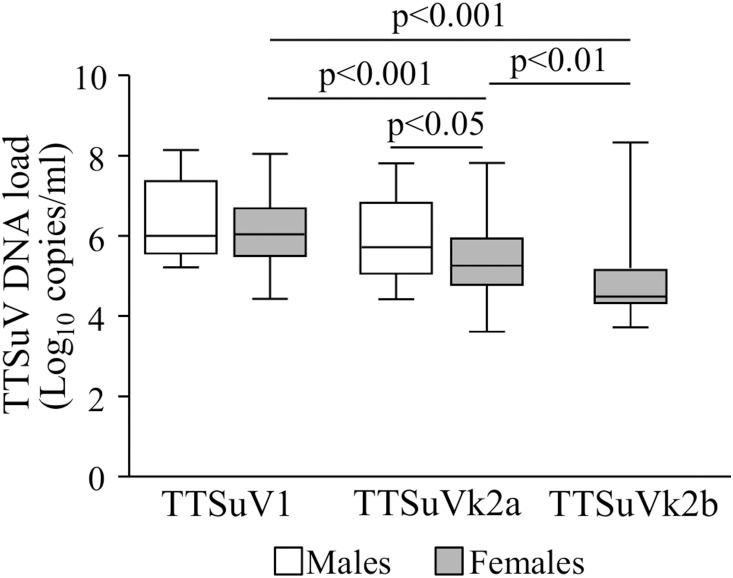
Box plots TTSuV DNA load in the overall infections of male and female pigs.Significant differences in mean viral load are indicated by p values.